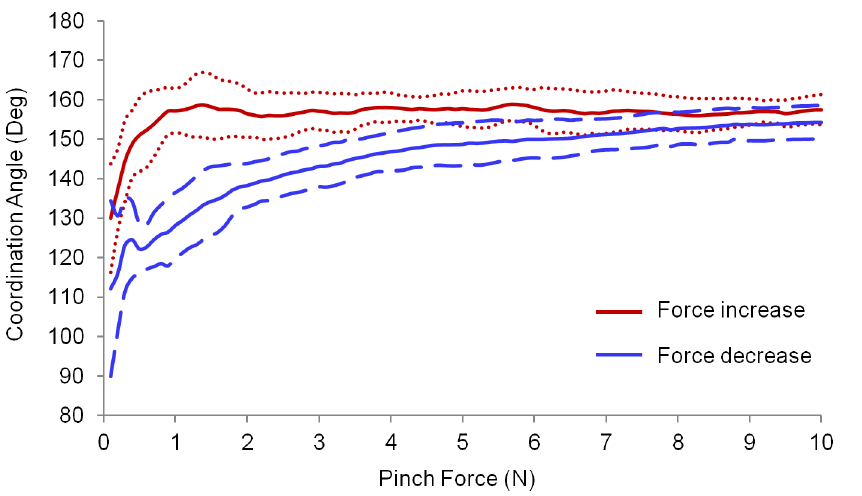
Figure 4. Coordination angles of the two force vectors at different pinch force magnitudes during increasing and decreasing force conditions. The solid lines represent the average of CA across all trials. The dotted/dashed lines represent the plus/minus standard deviations of CA for all trials.